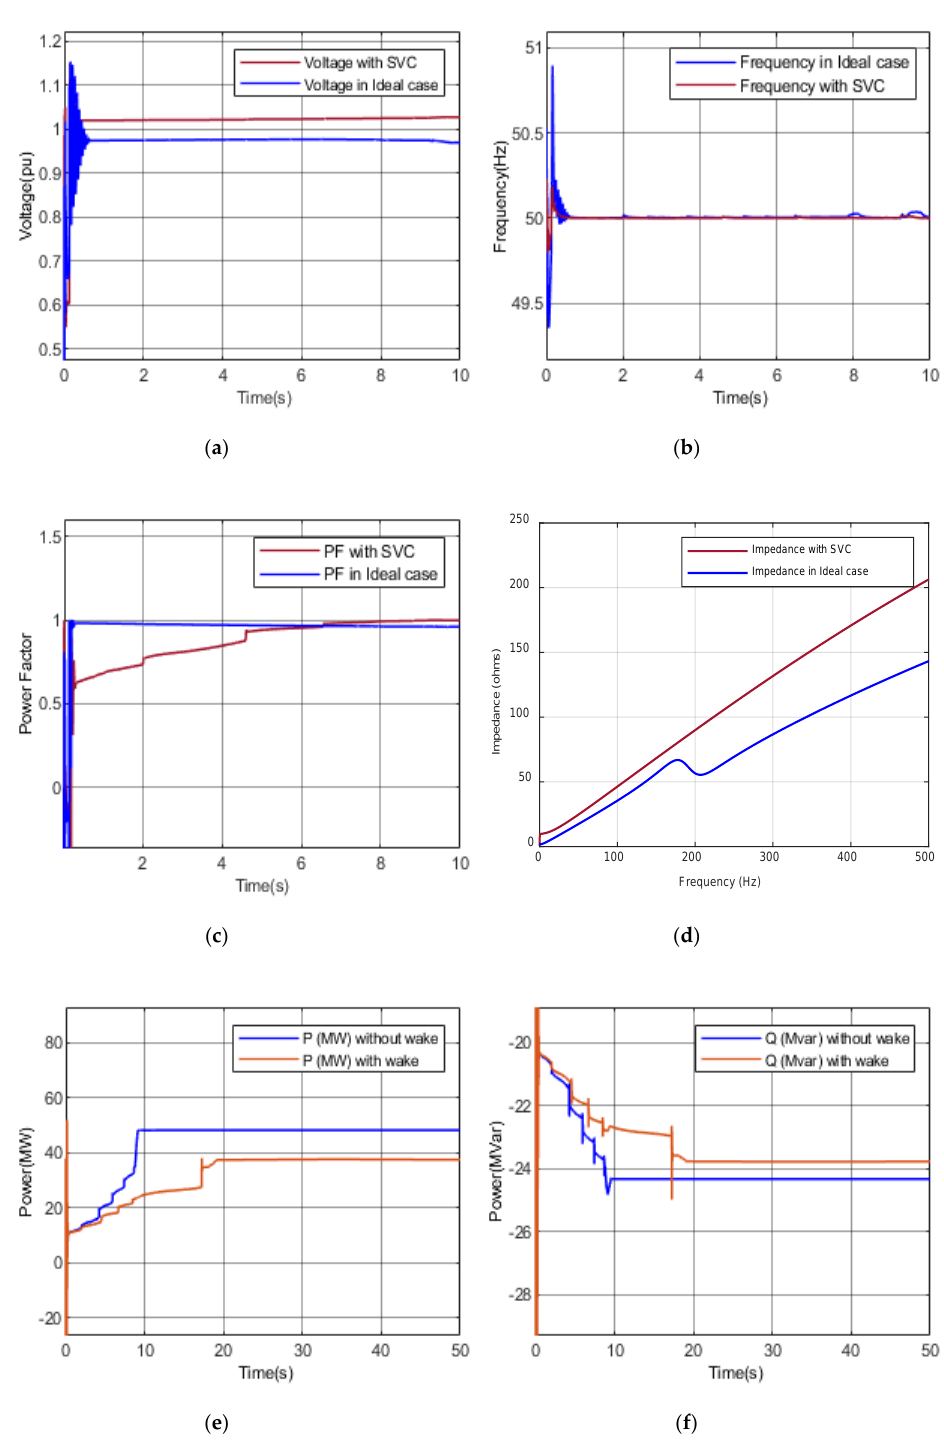
Figure 10. Case-2, Scenario 7: ( a ) Voltage (V) at PCC; ( b ) frequency (F) at PCC; ( c ) PF at PCC; ( d ) impedance (Z) vs. F; ( e ) P-trend; and ( f )